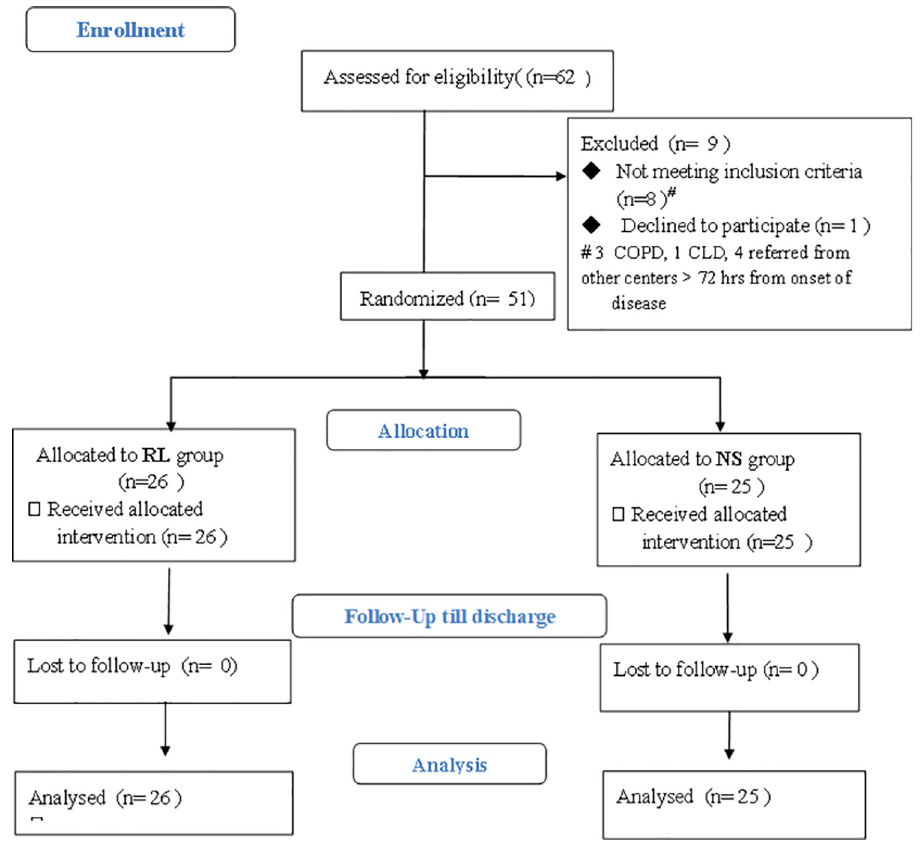
Fig 1. Consort flow diagram of the participants in the